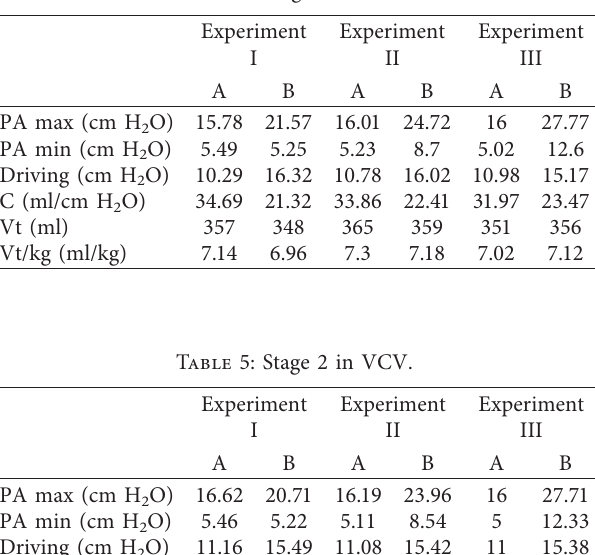
Table 4: Stage 2 in PCV.